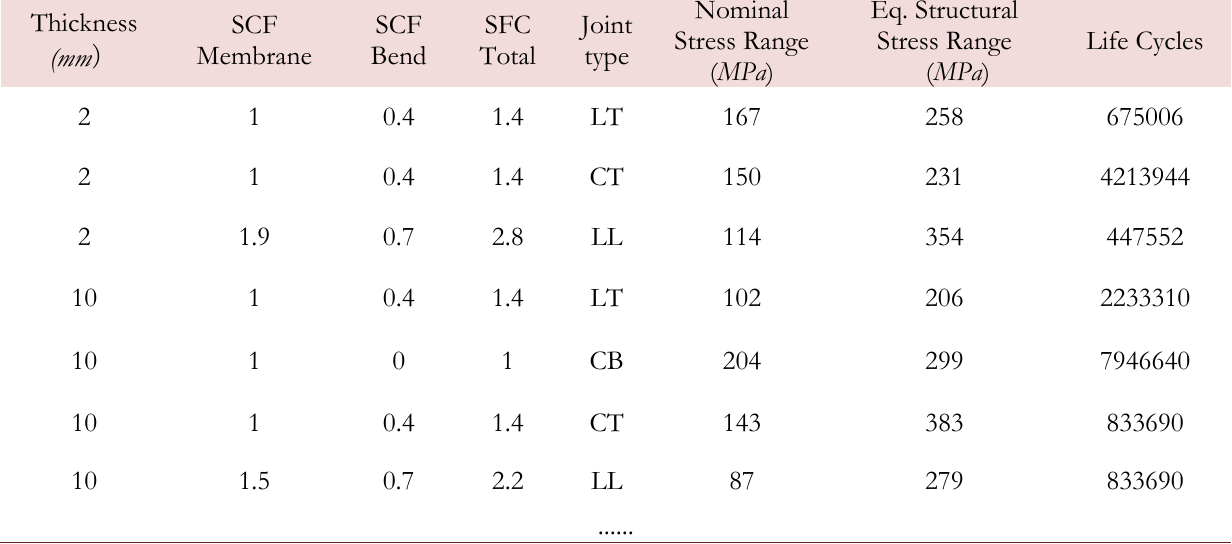
Table 5: Partial fatigue